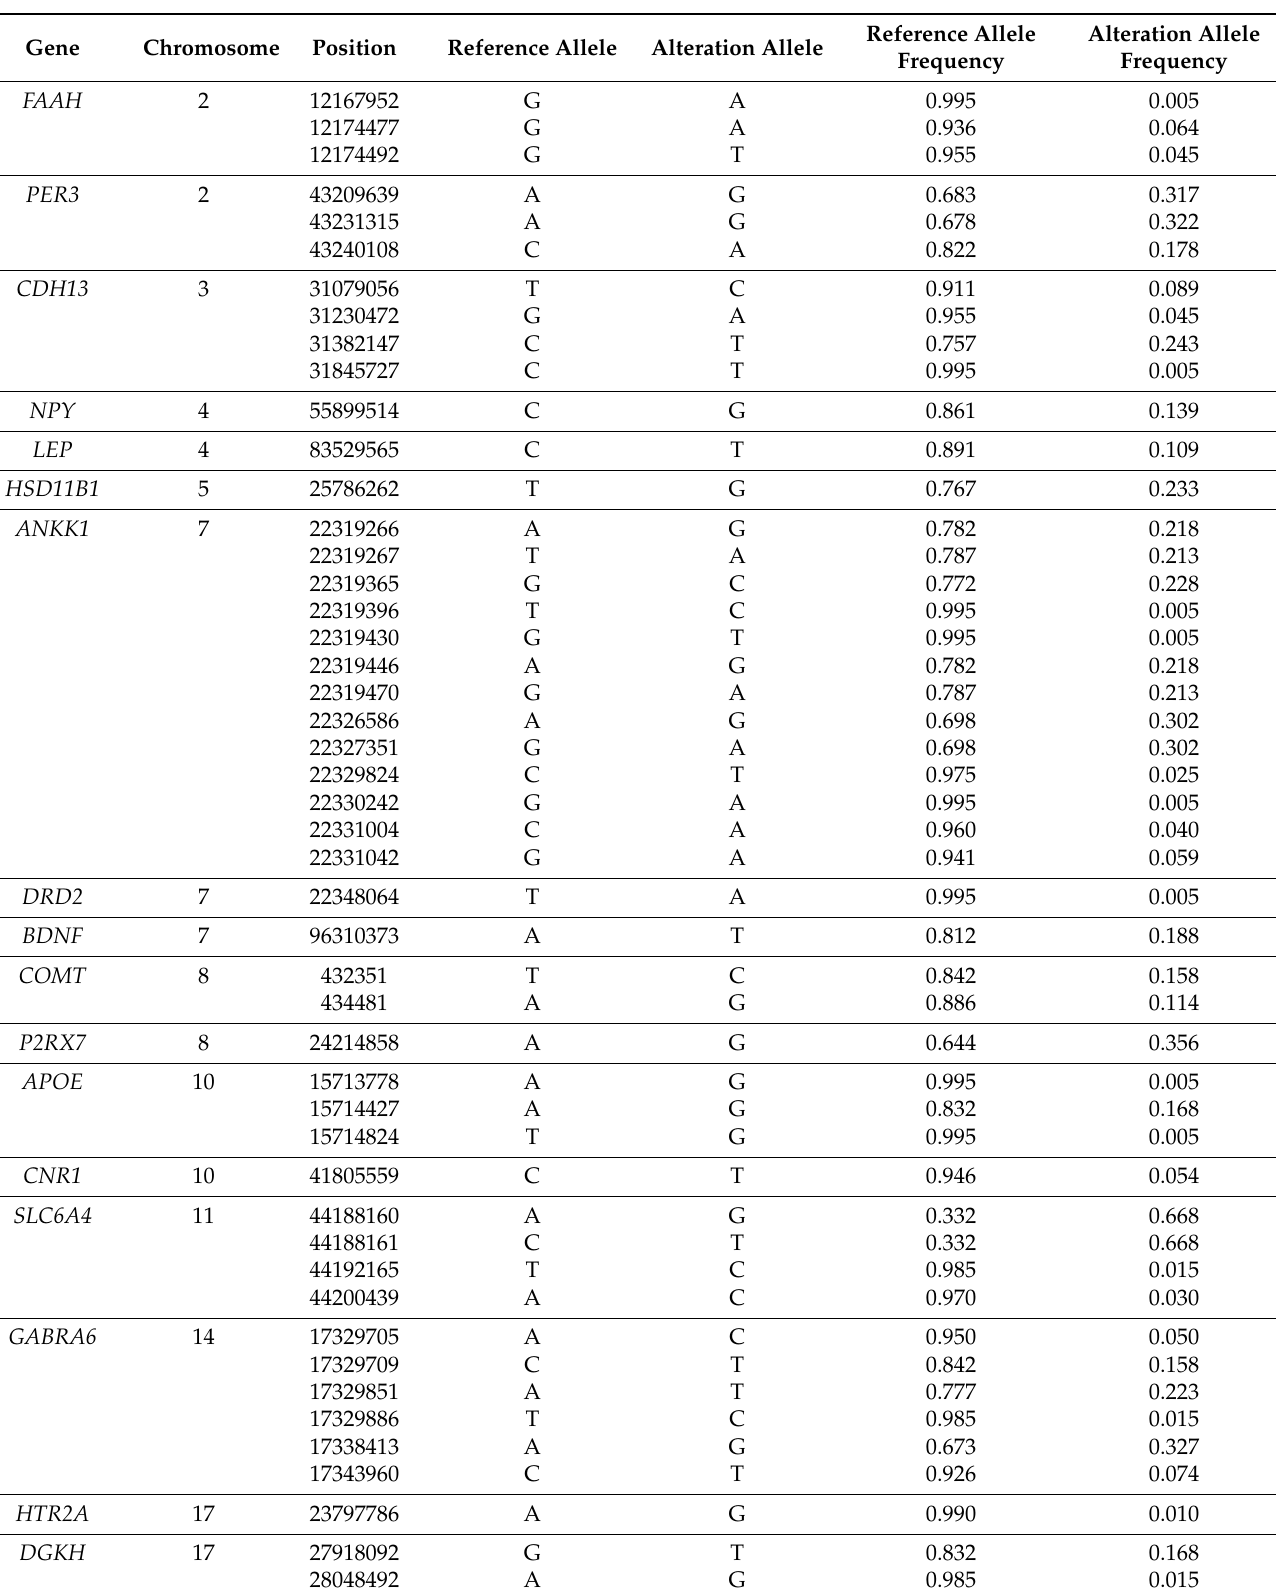
Table 2. Alleles and variant frequencies in the 18 most frequently identified equine personality- related